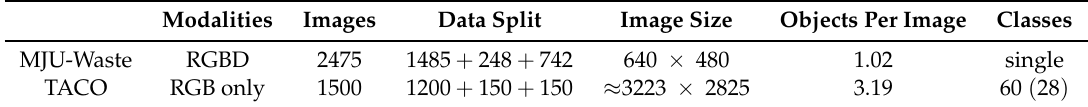
Table 1. Key statistics of the two datasets used in our experimental evaluation. Data splits are the number of training + validation + test images. The image size varies in TACO so we report the average image size here. Currently, MJU-Waste uses a single class label for all waste objects (in addition to the background class). For TACO, there are 60 categories which belong to 28 super (top) categories.